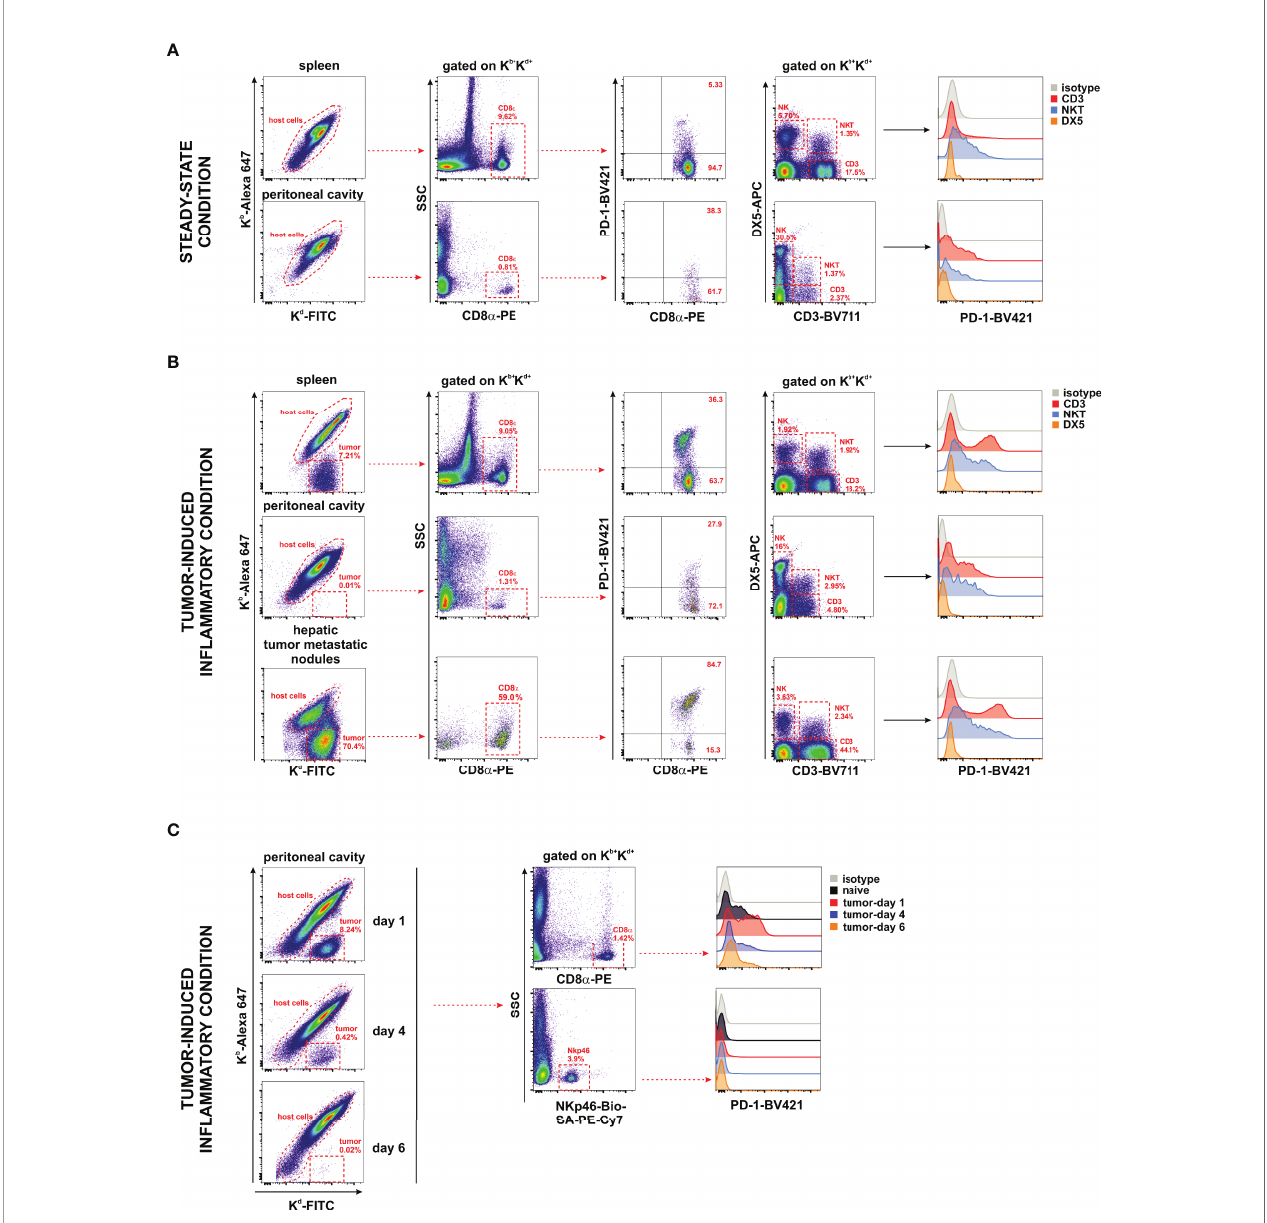
FIGURE 6 | Undetectable PD-1 expression on NK cells under homeostatic or in fl ammatory conditions. Naive F1 mice (A) or A20 WT tumor-bearing F1 mice (B) were analyzed for the expression of PD-1 on NK cells (CD3 − /DX5 + ), NKT cells (CD3 + /DX5 + ), CD3 T cells, and CD8 T cells collected from the peritoneal cavity and spleen of naive mice (steady-state conditions) and from the spleen, peritoneal cavity, and liver metastases of tumor-bearing mice. Host immune cells co-expressing K b+ /K d+ were differentiated from K b − /K d+ tumor cells in F1 mice injected with tumor cells. Representative dot plots of the analysis strategy in the spleen and metastatic nodules of the liver of F1 mice euthanized at day 30 after tumor implantation. One representative experiment out of three with similar results is depicted. (C) Time course expression of PD-1 on CD8 T cells and NK cells (NKp46 + cells) of the peritoneal cavity exposed to A20 WT tumor cells. Left panel: Representative dot plot showing host cells versus tumor cells remaining over the period of 6 days offollow-up depicting the kinetics of tumor rejection at days 1, 4, and 6 after tumor implantation. Right panel: Representative dot plot illustrating the gating strategy of CD8 T cells and NKp46 + NK cells for the analysis of PD-1